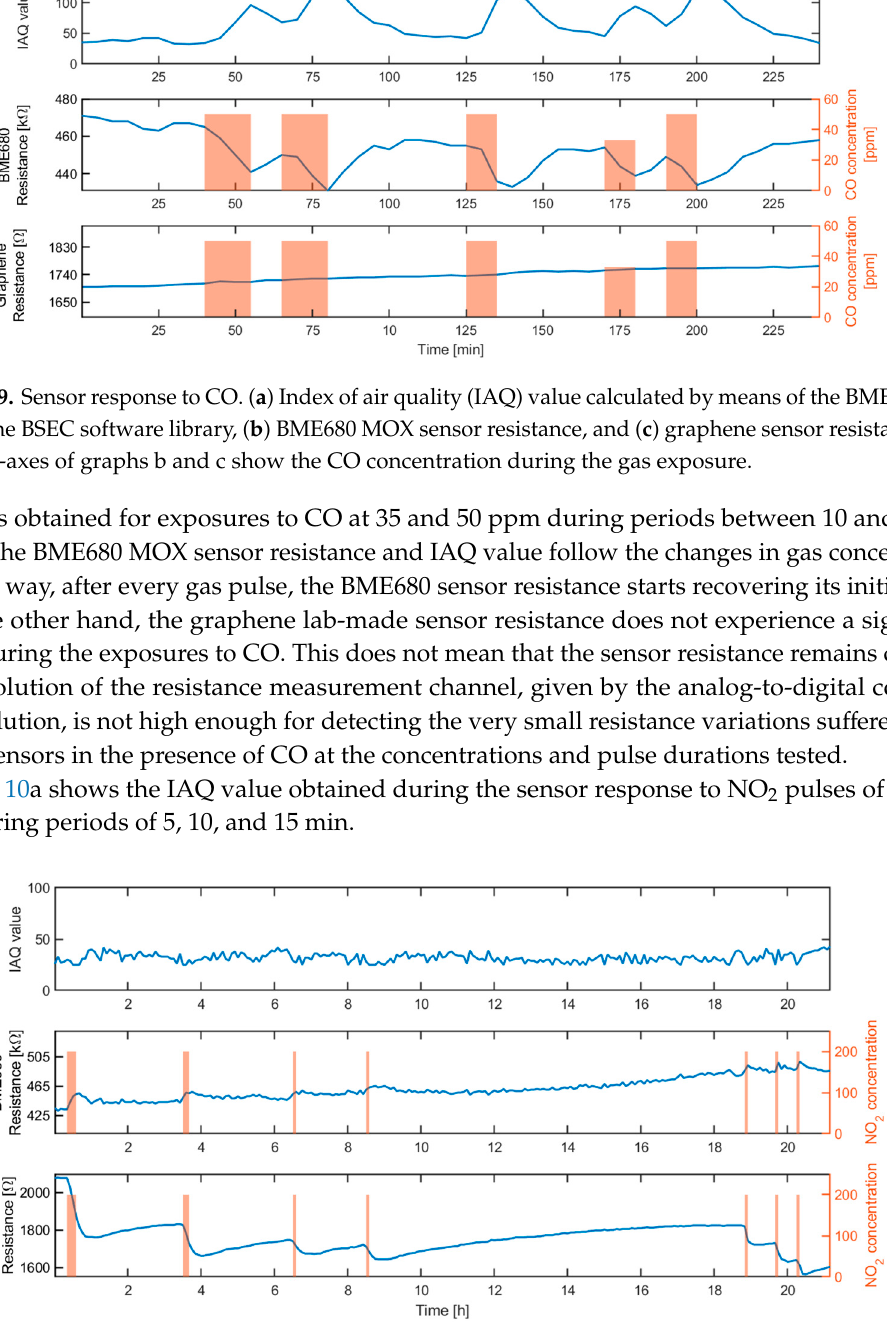
Figure 10. Sensor response to NO 2 . ( a ) IAQ value calculated by means of the Bosch Sensortec Environmental Cluster (BSEC) software library using the BME680 sensors exclusively, ( b ) BME680 metal oxide (MOX) sensor resistance, and ( c ) graphene sensor resistance. Right y-axes of graphs b and c show the NO 2 concentration during the gas exposure.